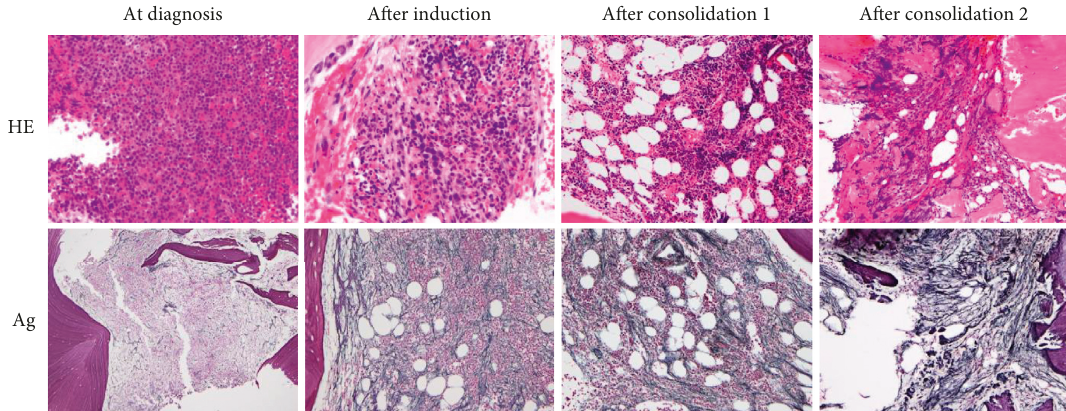
Figure 4: Serial bone marrow biopsies (hematoxylin-eosin (HE) and silver staining (Ag)). Only mild reticulin fibrosis was observed at the time of diagnosis. Fibrosis progressed as treatment progressed, and collagenous fibrosis was recognized. Magnification, 40x.